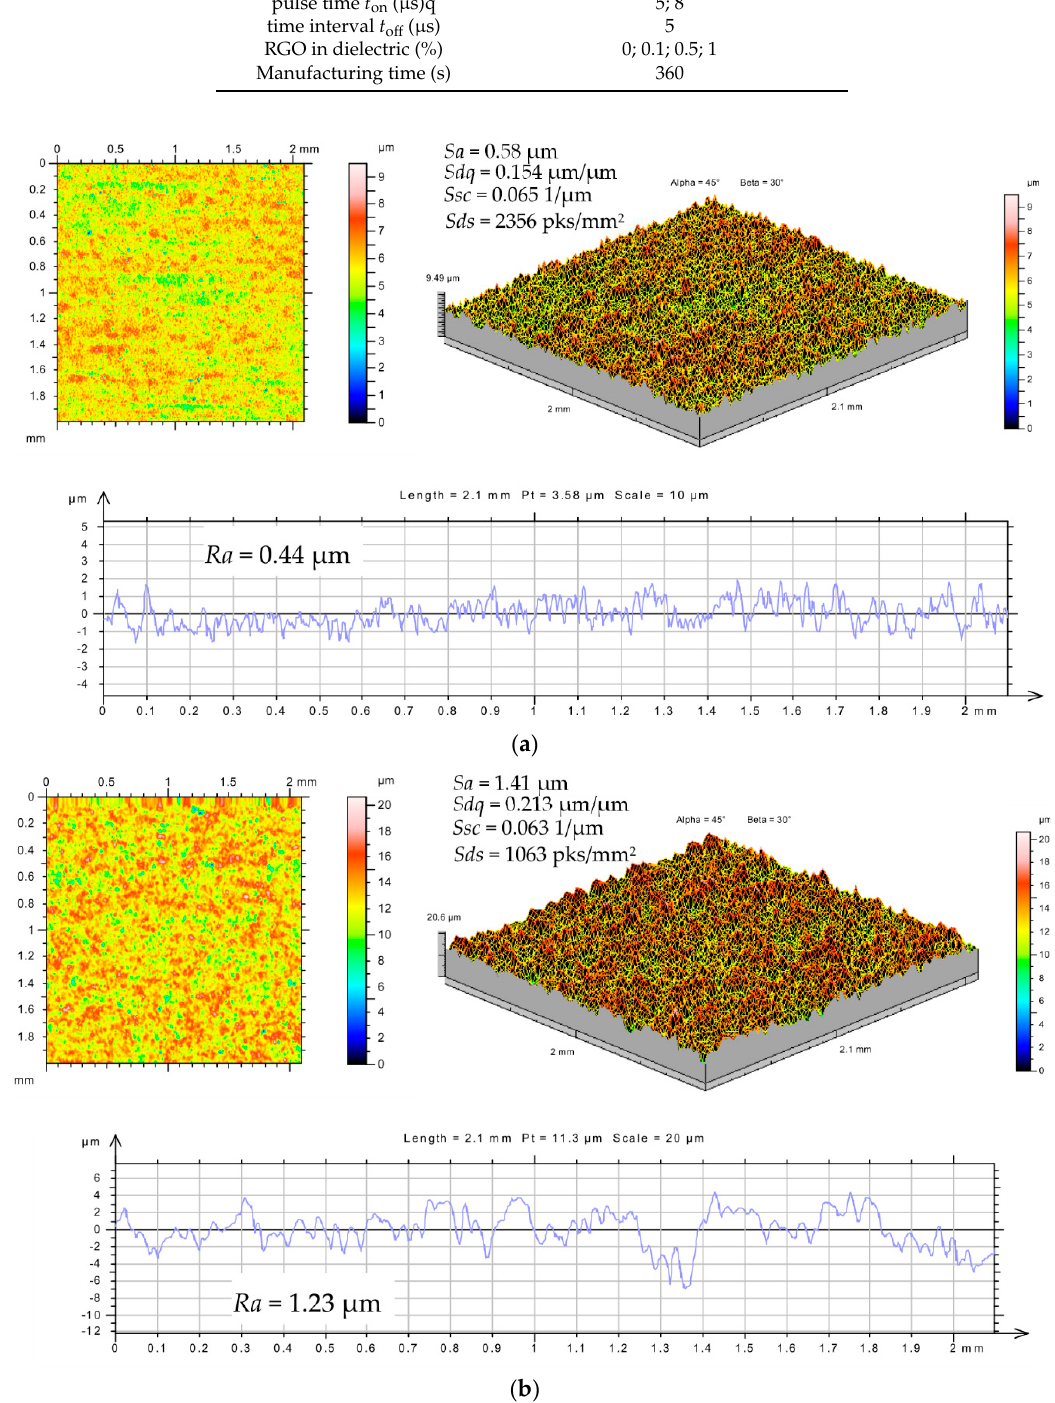
Figure 6. The surface texture of the tool steel 55NiCrMoV7 after EDM ( U c = 25 V, I = 1 A, t on = 5 µs, t off = 5 µs) with positive polarity ( a ) in dielectric with 0.1% RGO and ( b ) in the pure dielectric.